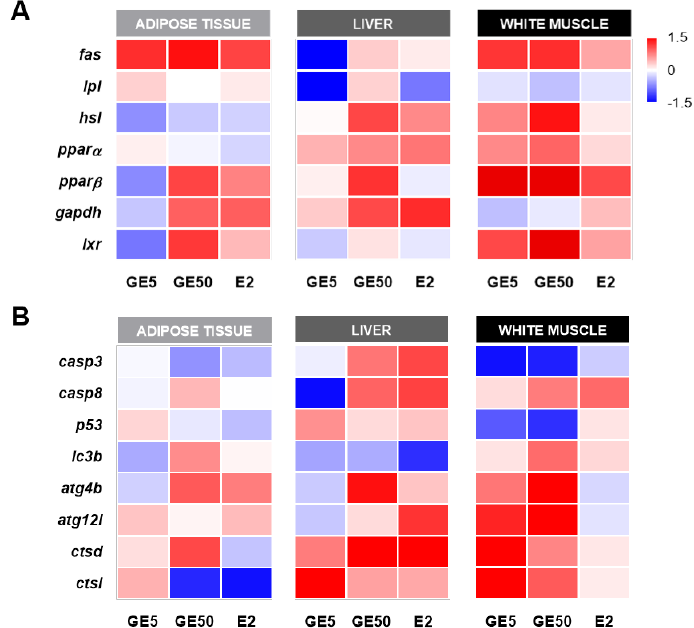
Figure 8. Comparative heat maps showing the changes in ( A ) lipid metabolism and ( B ) apoptosis- and autophagy-related genes expression among adipose tissue, liver, and white muscle in rainbow trout intraperitoneally injected with GE 5 μg/g, GE 50 μg/g, or E2 5 μg/g . Gene expression was first calculated relative to the geometric mean of the corresponding reference genes for each tissue, and then it was standardized following a standard score normalization (log2) against the corresponding control (CT) samples. Shades of red and blue, respectively, indicate the highest and lowest expression levels, as specified in the scale bar of the figure. GE: Genistein; E2: 17β-estradiol.